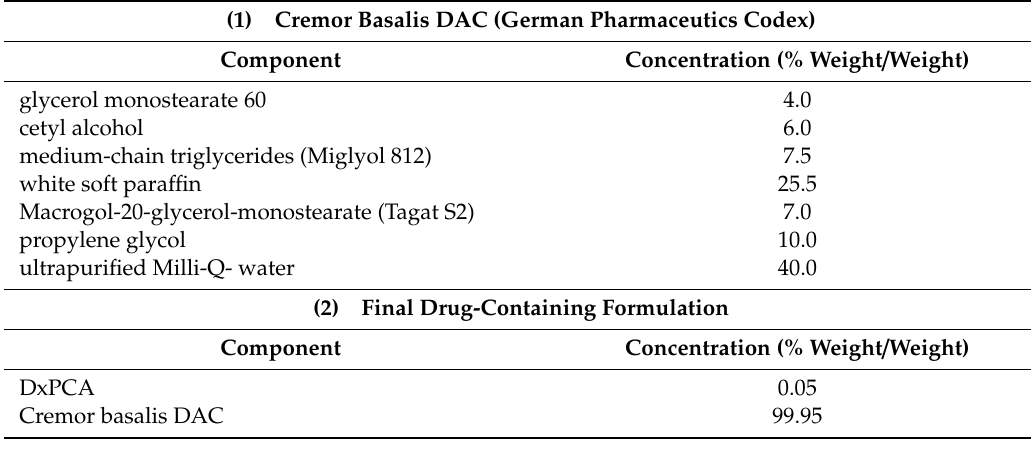
Table 1. Overview of the composition, with the respective concentration of each component of the cremor basilis (1) and the final drug-containing formulation (2); dexamethasone– 3-(carboxy)-2,2,5,5 -tetramethyl-1-pyrrolidinyloxy